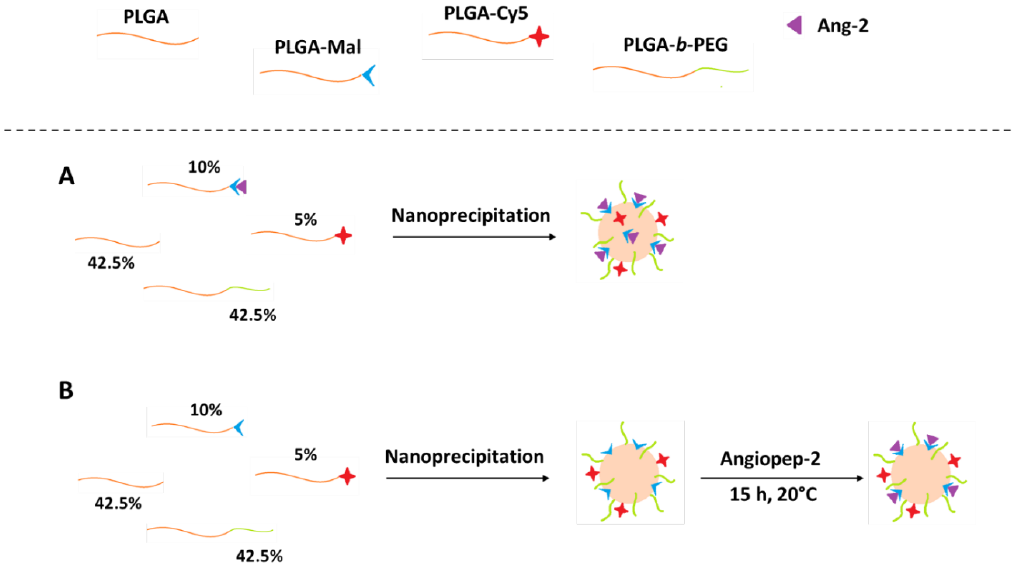
Figure 2. Schematic representation of the modification of PLGA/PLGA- b -PEG nanoparticles with Ang-2 through ( A ) pre-functionalization and ( B )